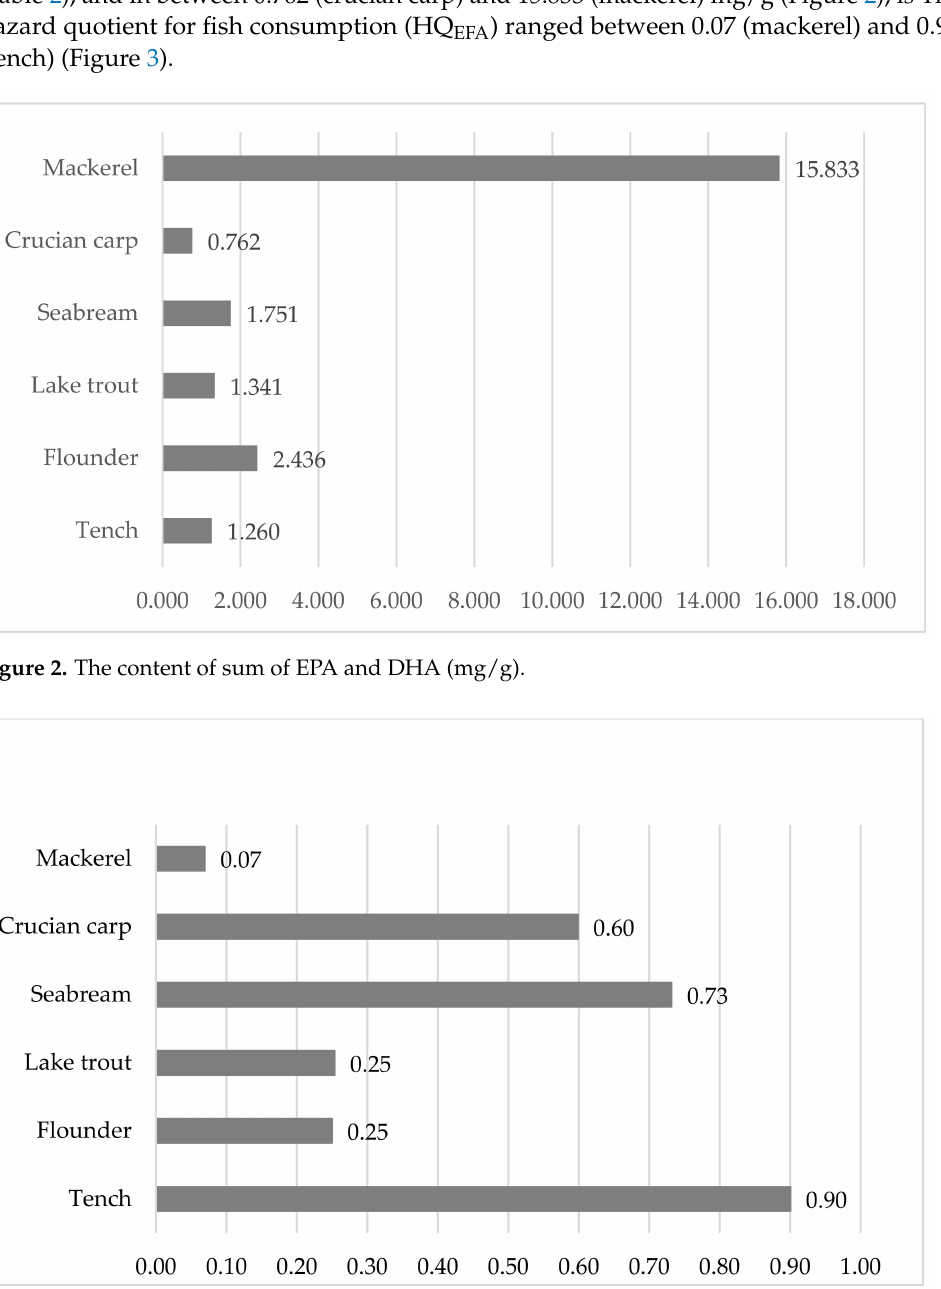
Figure 3. HQ EFA is the hazard quotient for fish consumption when a person obtains from the fish the recommended dose of